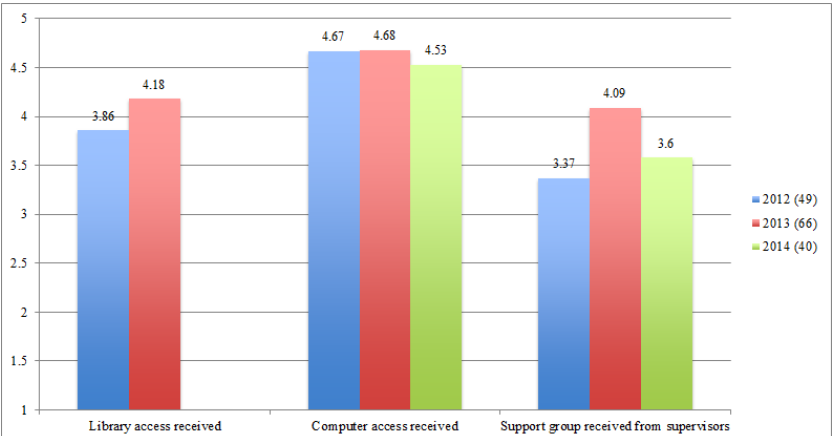
Figure 5. Mean rating of the personal experience of support given during Week